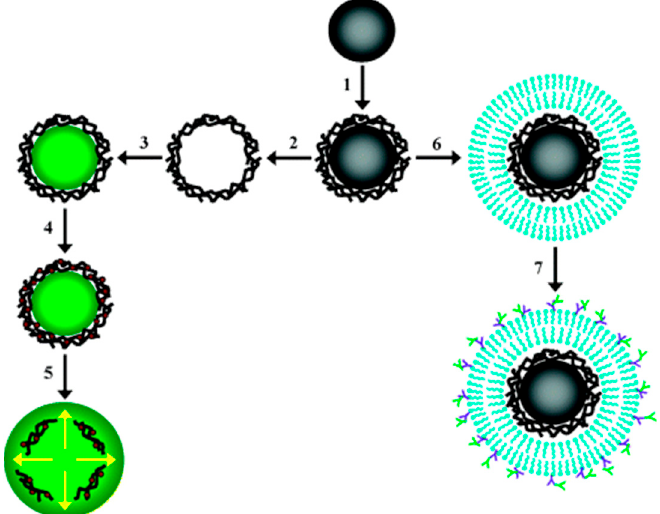
Figure 8. Schematic illustration of the various colloidal systems investigated by Angelatos et al. [76]. Reprinted with permission from [76]. Copyright 2005 American Chemical Society.